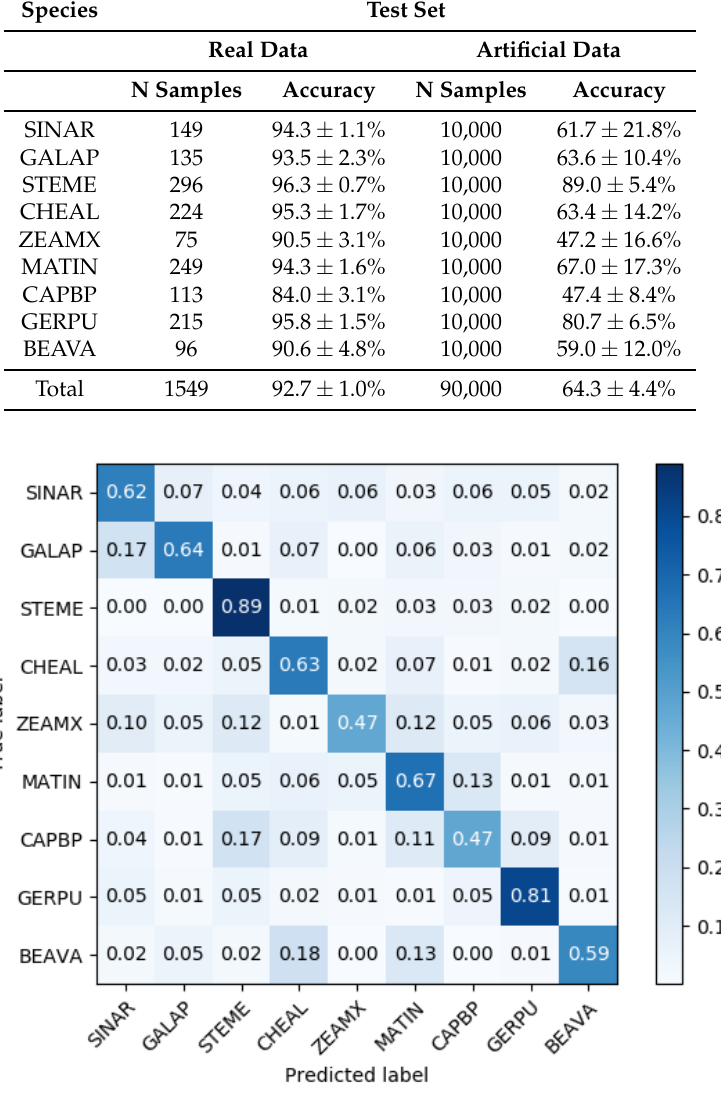
Figure 4. Average confusion matrix when evaluating the artificial samples from the WacGAN-info model using the external classifier trained solely on real samples. Each row is normalized with respect to the number of true labels of that